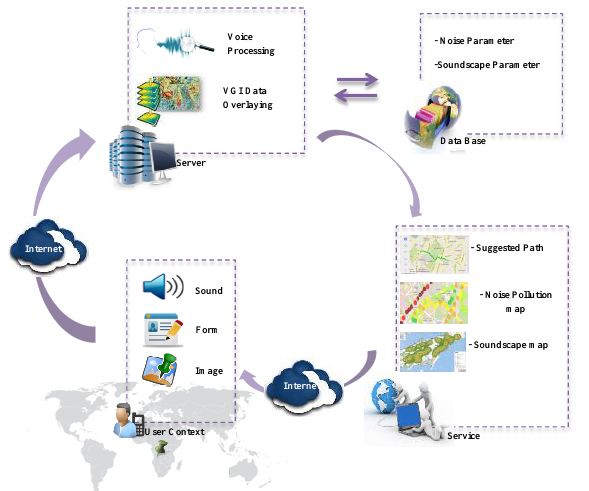
Figure 3: Application of UbiSound in real Environment